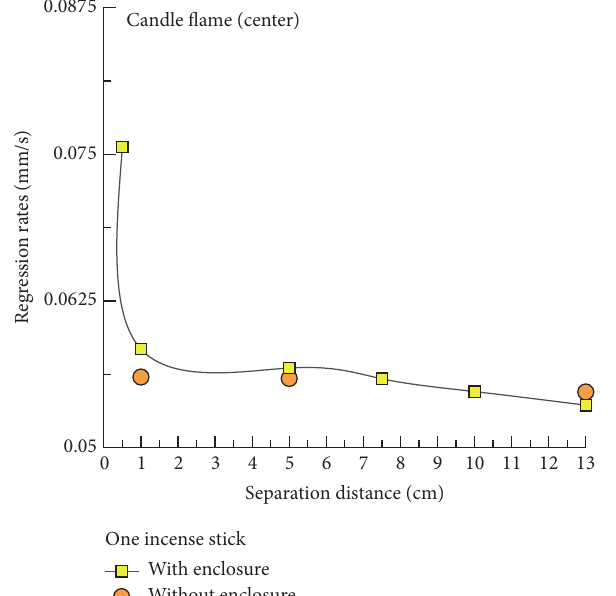
Figure 13: Enclosure effects on smoldering combustion.